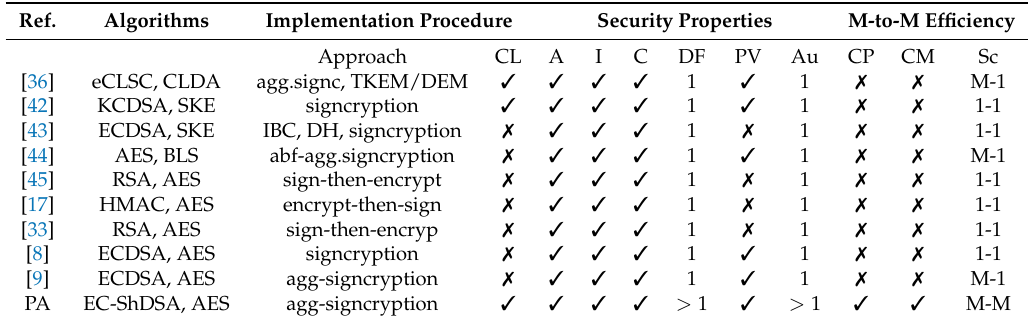
Table 1. Comparison with state-of-the-art approaches. Legend: CL: certificateless, A: